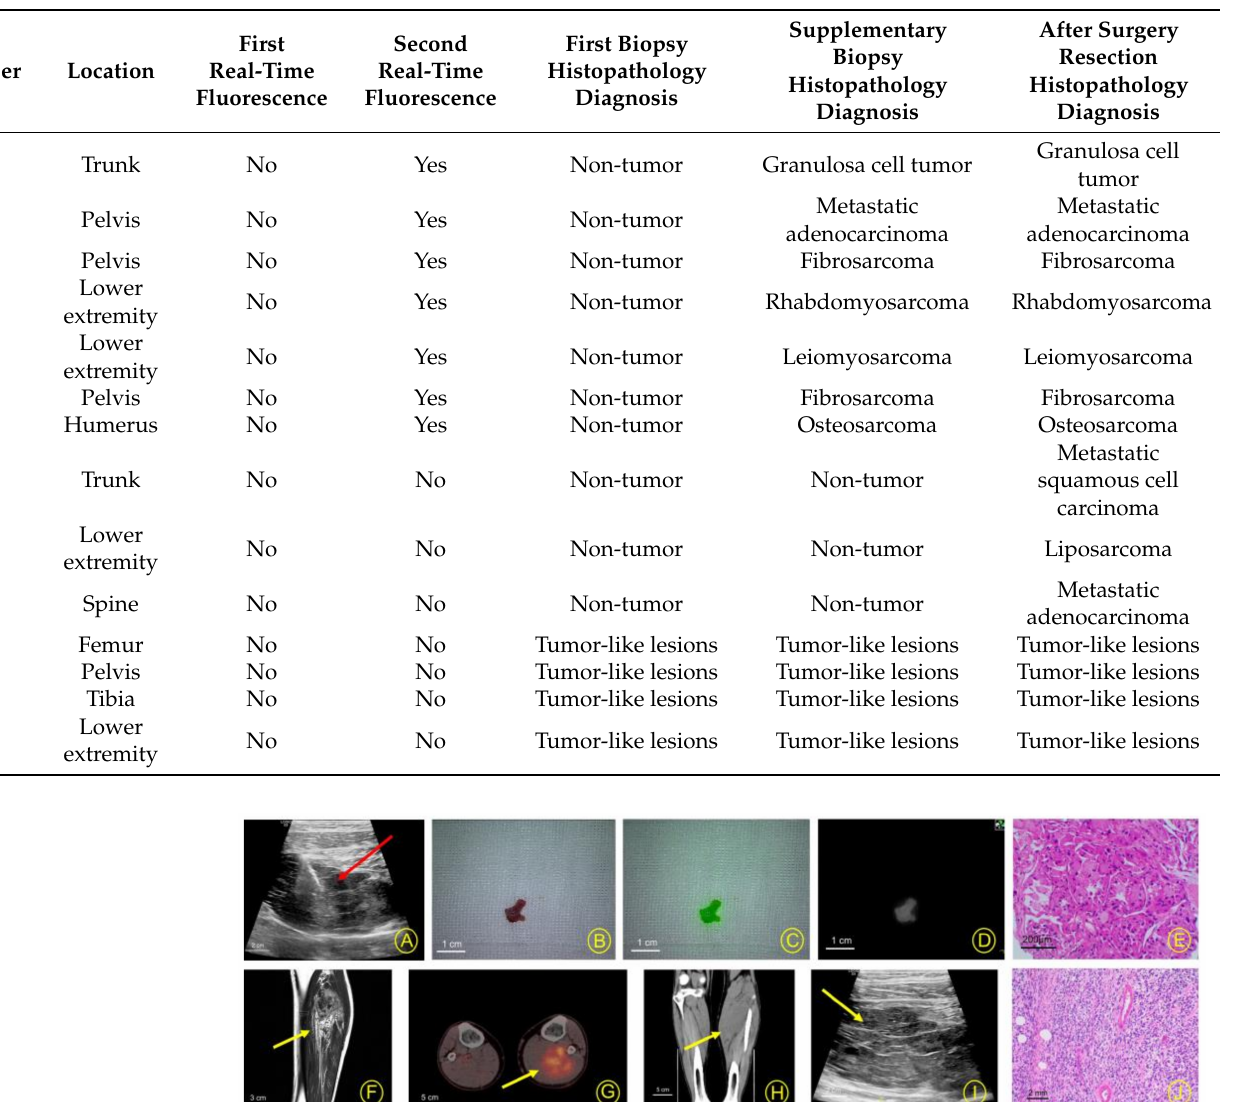
Table 5. Characteristics of 14 cases of first-time puncture specimens without real-time fluorescence development in the test group.